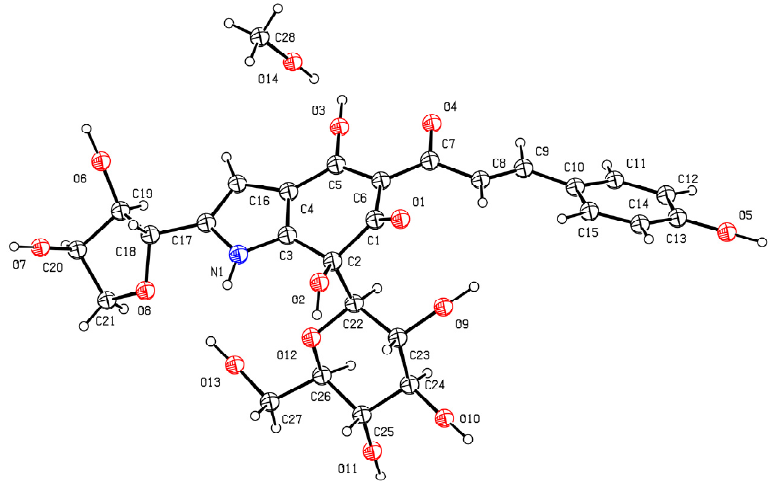
Figure 5. Perspective view of cartormin